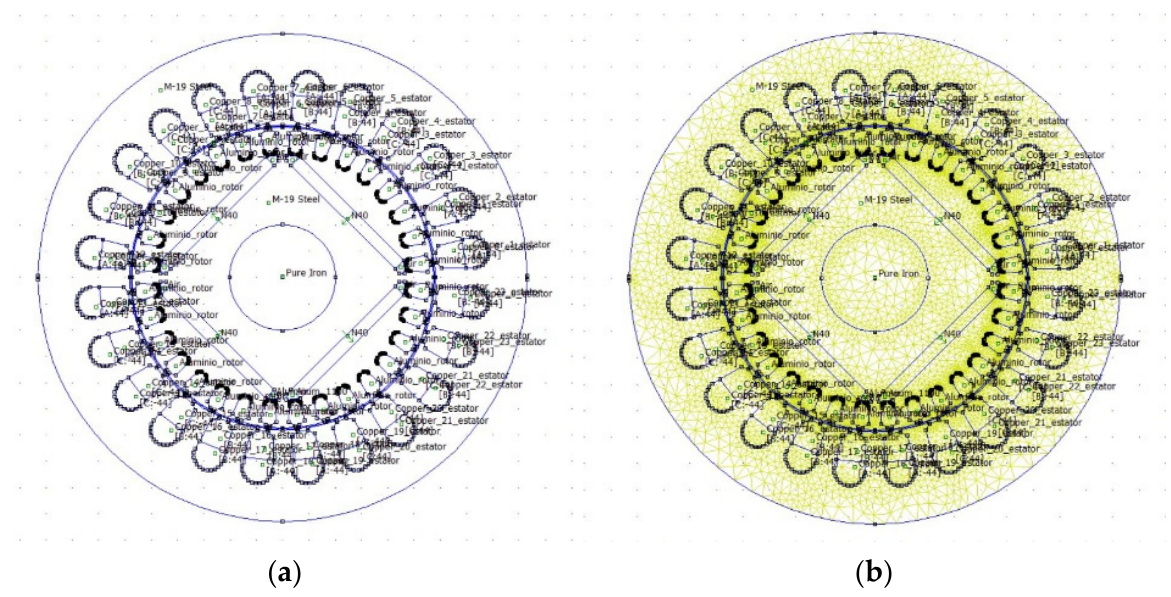
Figure 12. Line-start permanent magnet motor simulation on FEMM: ( a ) LSPMM geometry and materials and ( b ) LSPMM mesh.